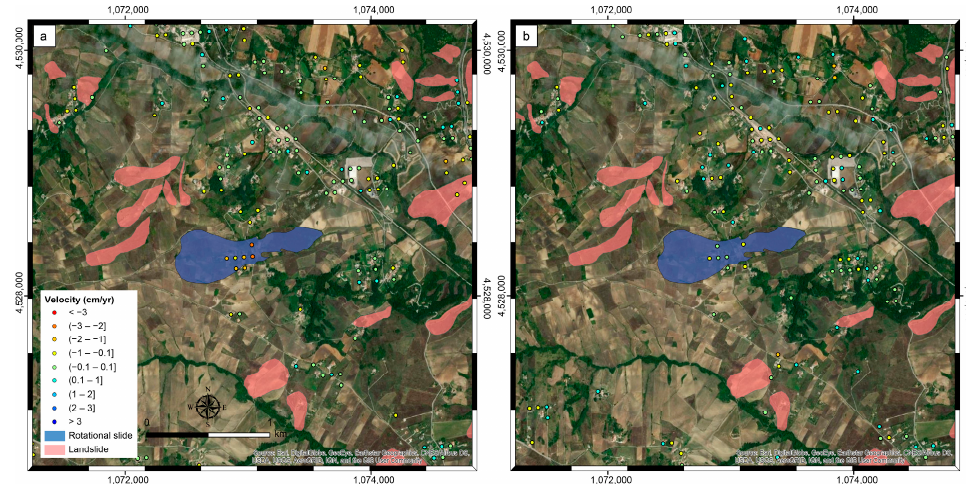
Figure 7. Boundary of the rotational slide (landslide 1 in Figure 6), with the points representing the pixels of surface displacements for the ( a ) T146 ascending orbit (9 pixels) and ( b ) T124 descending orbit (10 pixels), classified according to the average velocity of deformation over the five years of observation (2015–2020). Background from Google Earth.